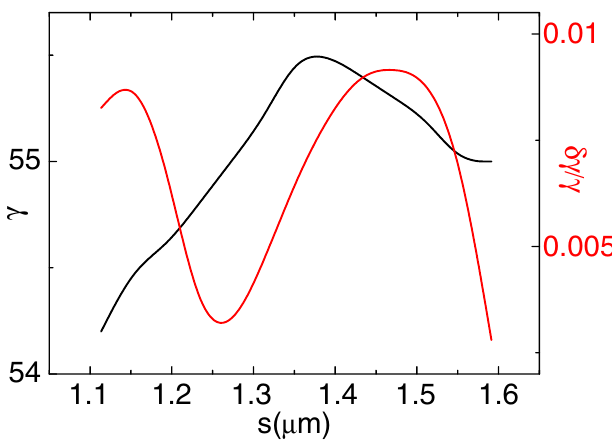
FIG. 8. (Color) Profile of (cid:3) and (cid:6)(cid:3)=(cid:3) vs s deduced by the VORPAL bunch.